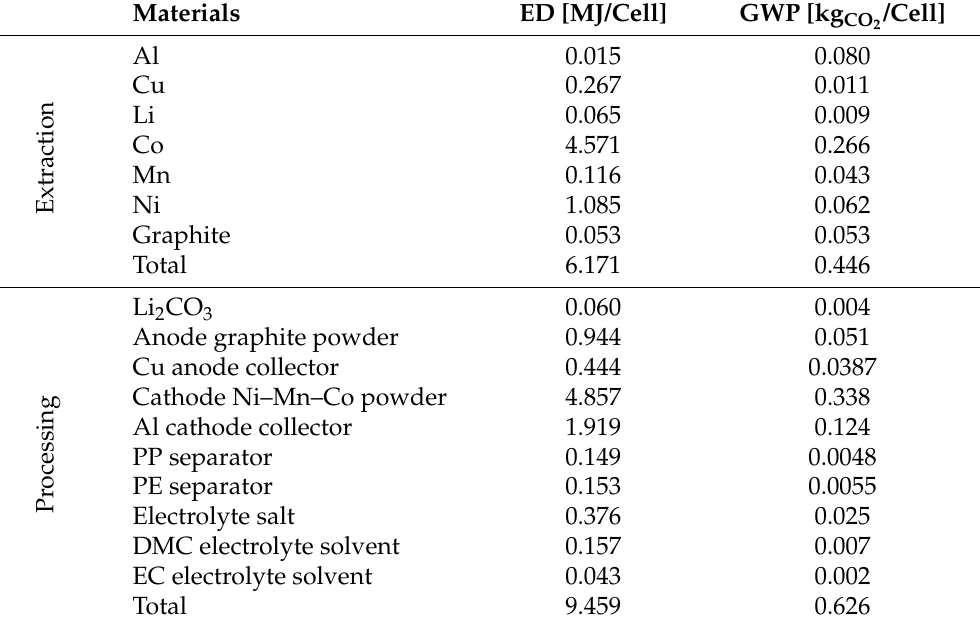
Table 5. Average ED and GWP related to the extraction and processing of the raw materials for one